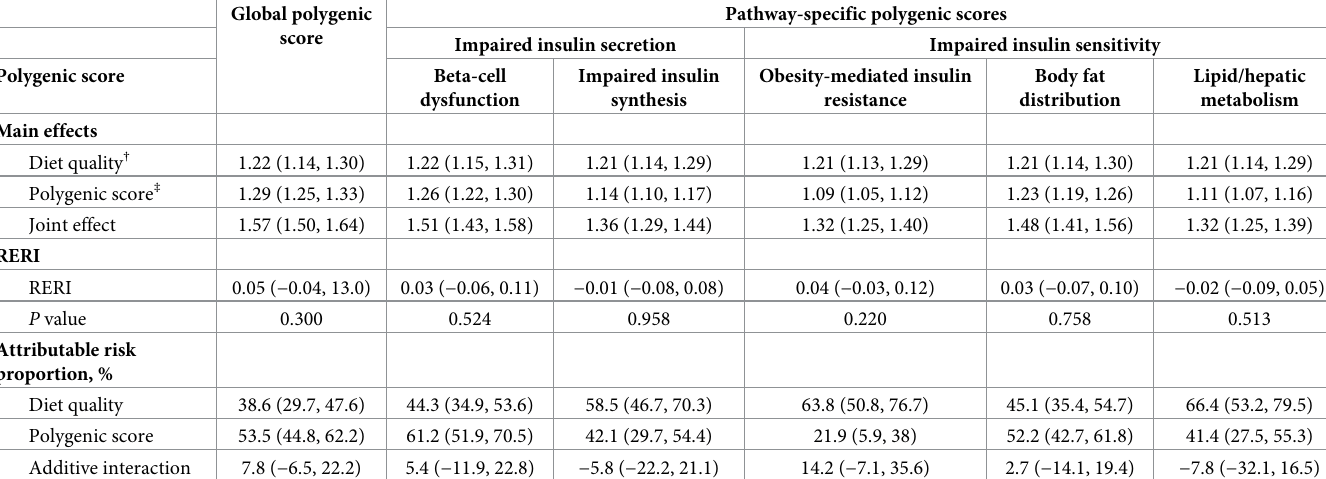
Table 4. Additive interactions between diet quality and genetic risk using global and pathway-specific polygenic